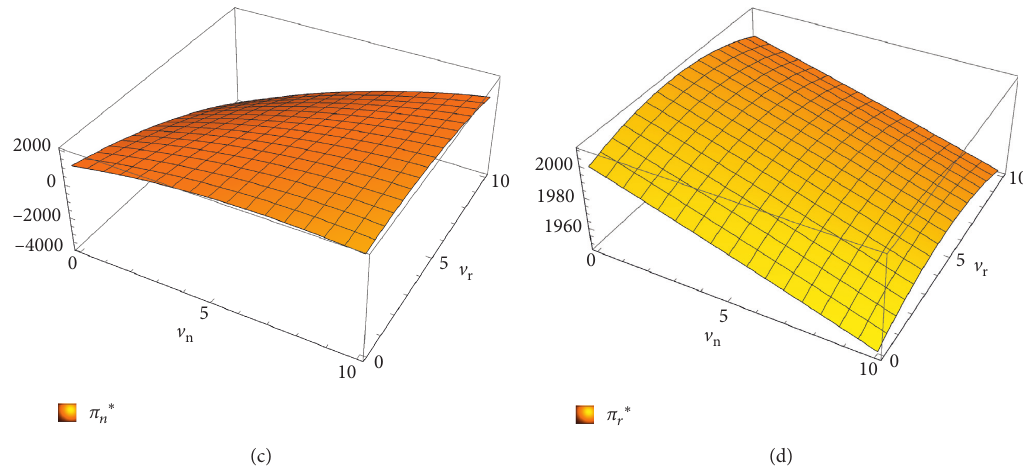
Figure 4: Impact of service level v and v on pricing and profit of recycling networks and automobile 4S stores: (a) the influence of recycling n r effort v on recycling prices p and p ; (b) the influence of recycling effort v n r n and v on the profit of automobile 4S stores; (d) the influence of recycling efforts v efforts v n r